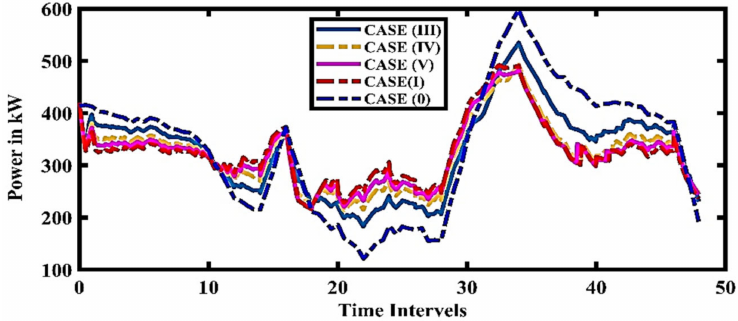
Figure 15. Microgrid power deviation for various cases.